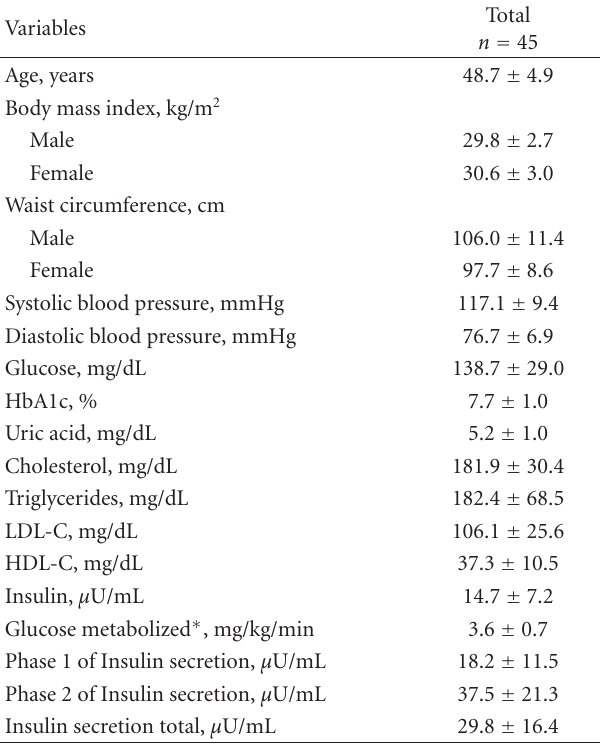
Table 1: Clinical and biochemical characteristics in study.